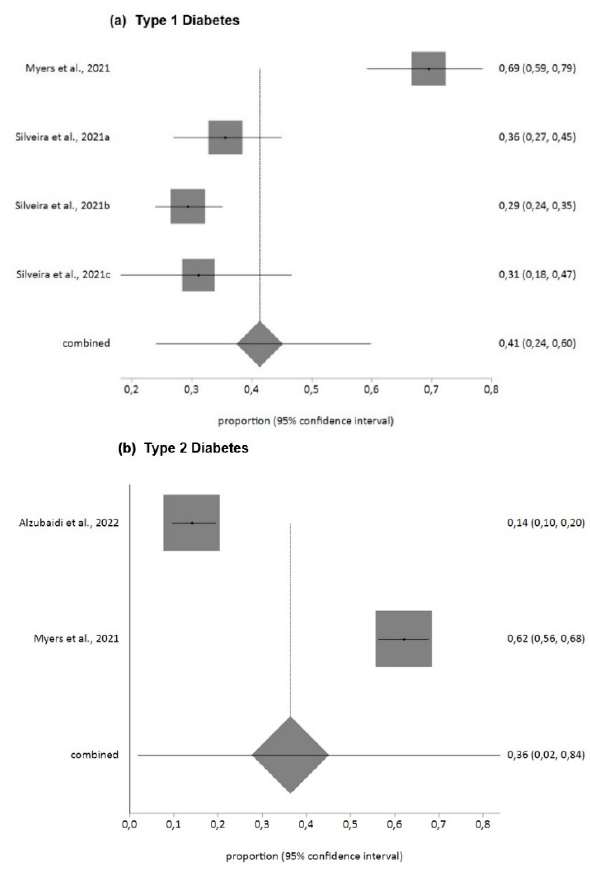
Figure 3. Prevalence of distress in DM patients during COVID-19 pandemic (DDS). ( a ) Type 1 Diabetes [52,60], ( b ) Type 2 Diabetes [32,52].